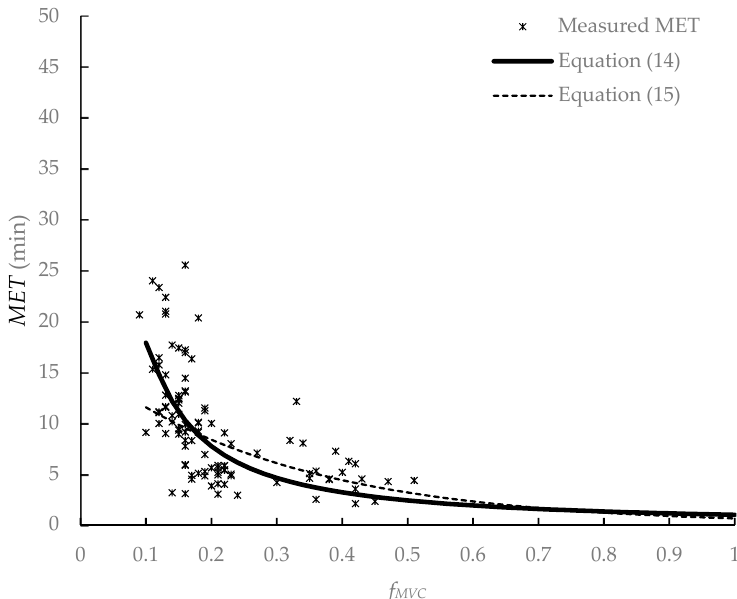
Figure 7. MET models for new data set. f MVC = forceful exertion/ MVC .